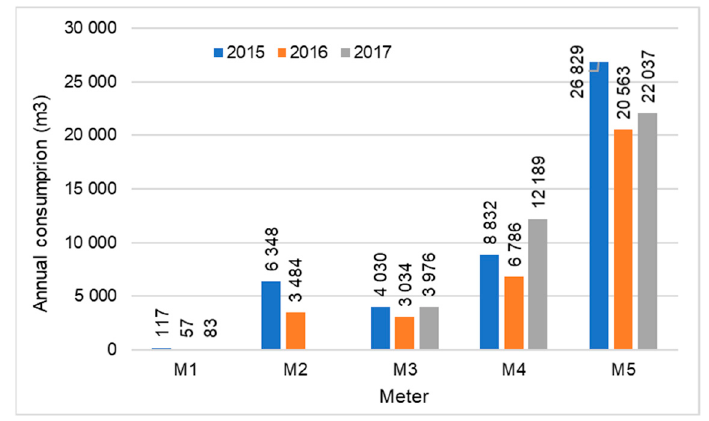
Figure 7. Measured water volumes in 2015, 2016 and 2017 (m 3 /year).